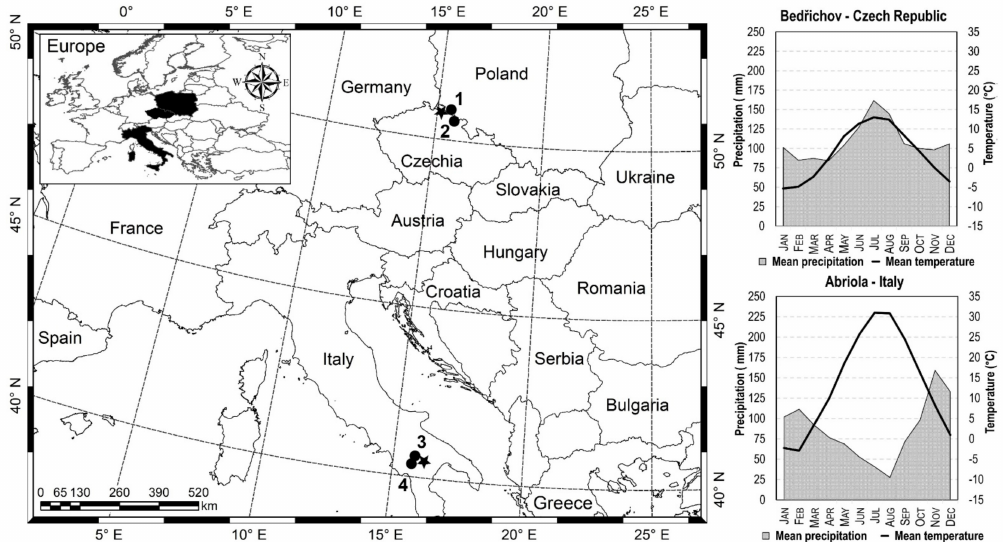
Figure 1. Location of permanent research plots (black dots) with monthly climatic characteristics of the mean precipitation and mean temperature in the meteorological stations (black stars) in Bedˇrichov, the Czech Republic, and Abriola, Italy, over the whole time period of 1900–2019. Table 2. Characteristics of tree-ring chronologies for European beech in research plots for 1900–2019. Plot